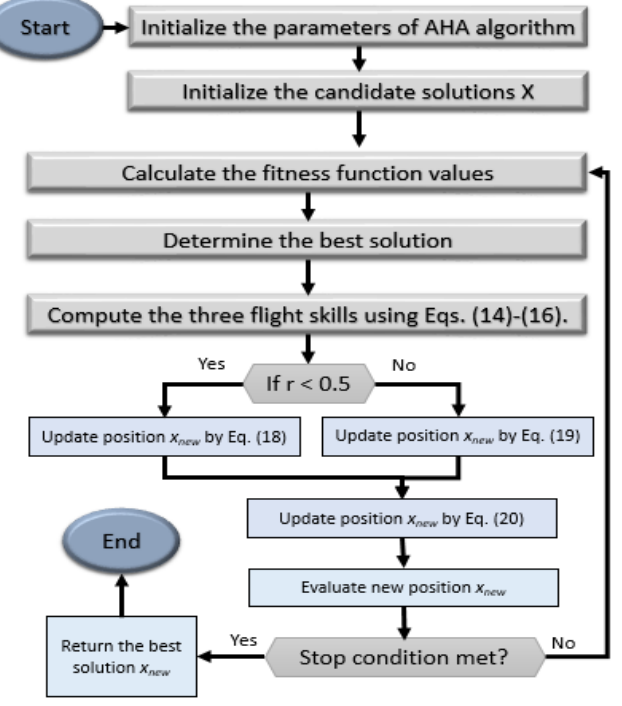
Figure 2. Steps of the